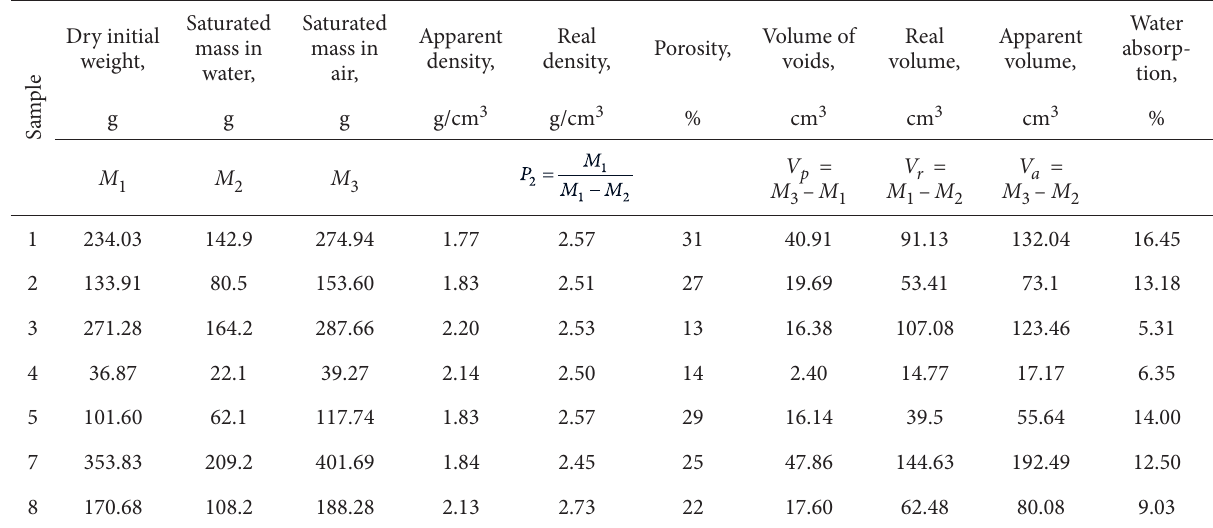
Table 5. Physical properties of the